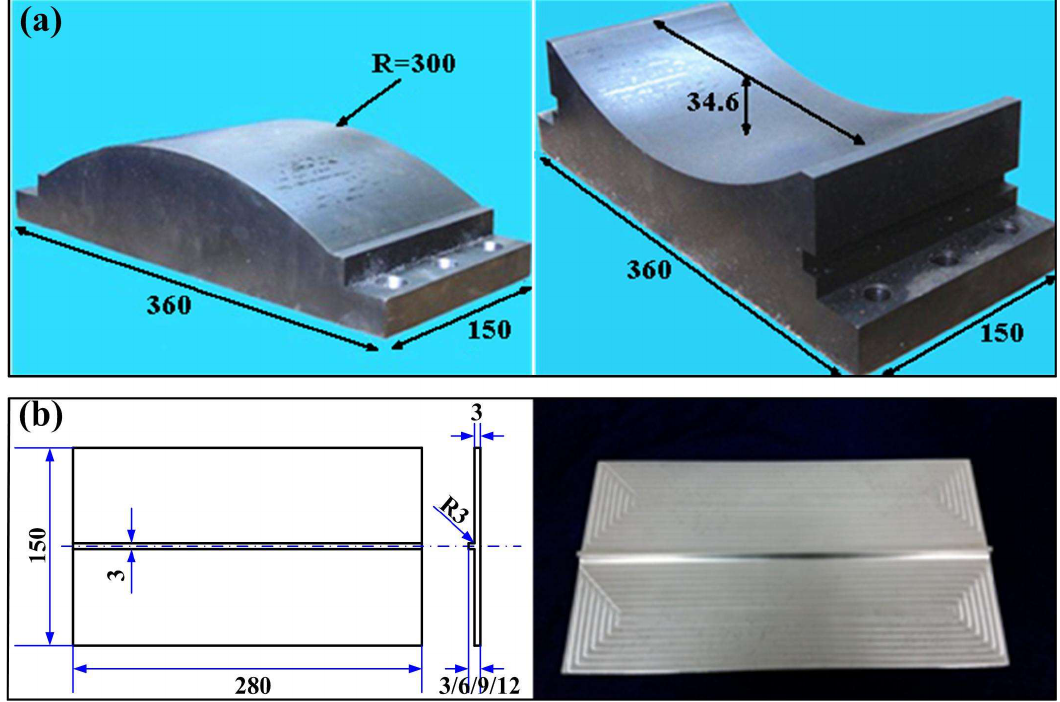
Figure 2. Geometries and dimensions of ( a ) upper and lower dies and ( b ) ribbed panels (unit: